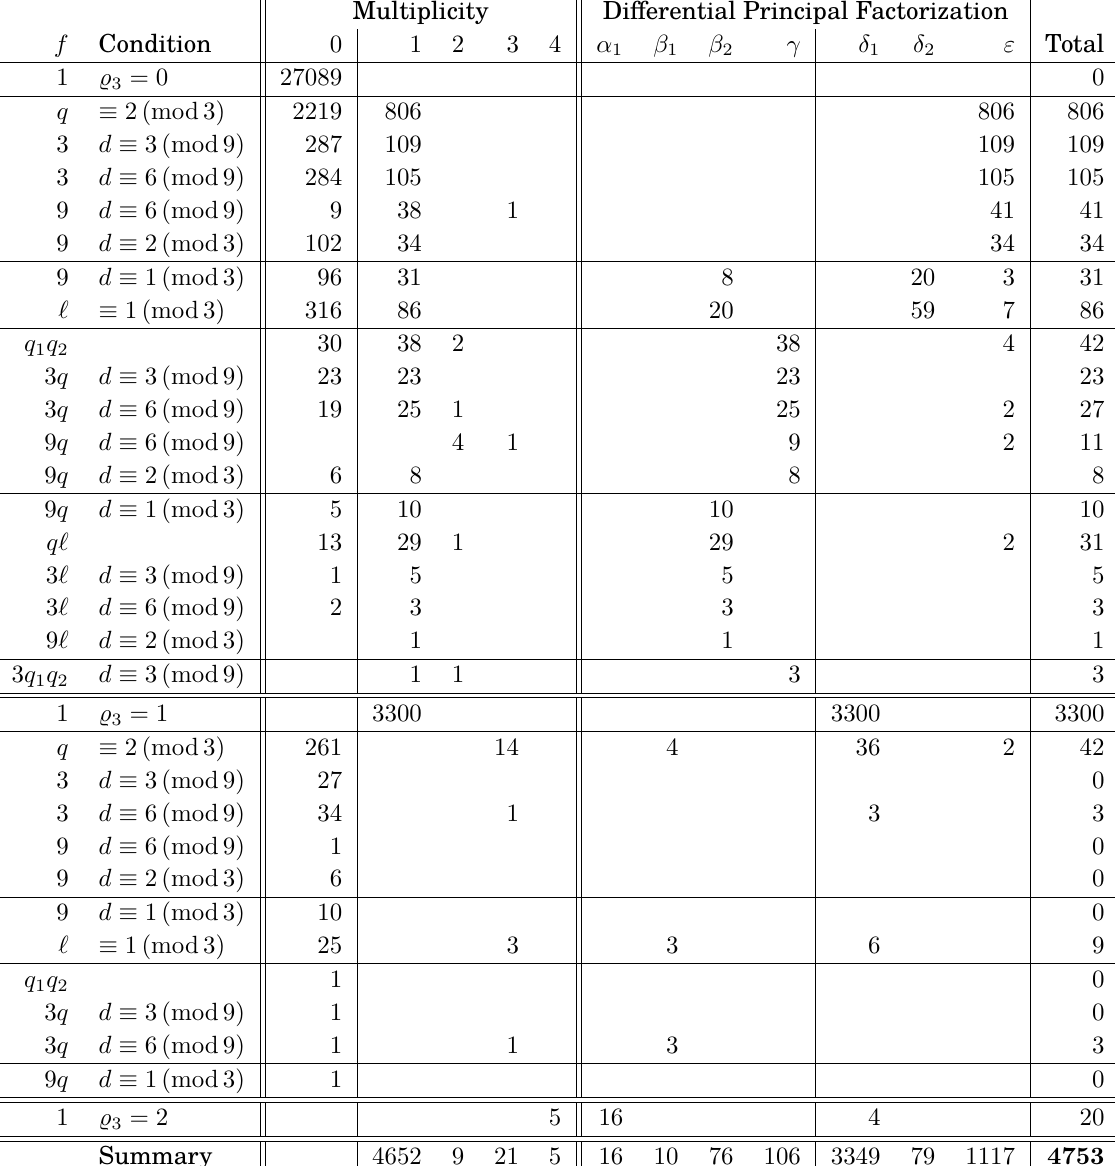
Table 1: Totally real cubic discriminants d L = f 2 · d in the range 0 < d L < 10 5 . Multiplicity Differential Principal